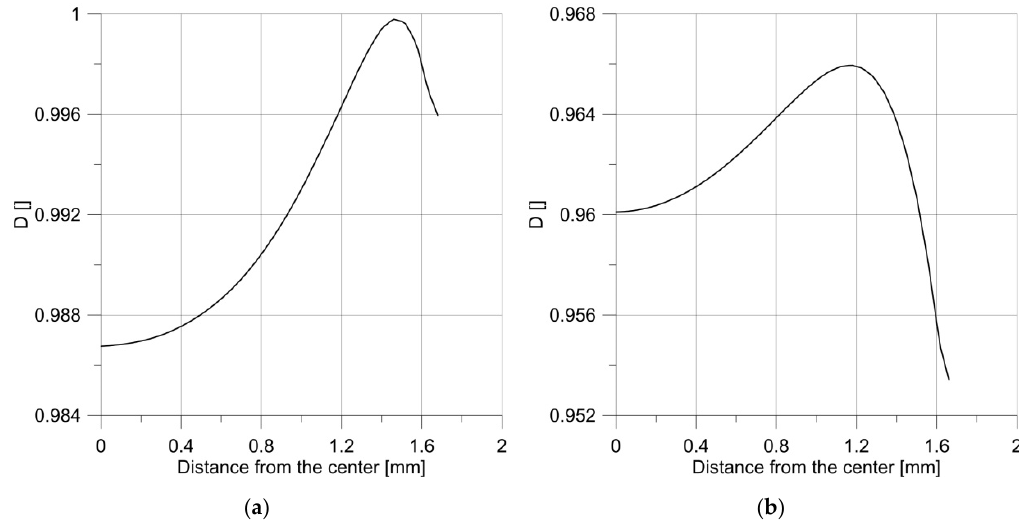
Figure 21. Distribution of the D parameter just before the crack initiation for the regular load ( a ) and the decreased load ( b ).